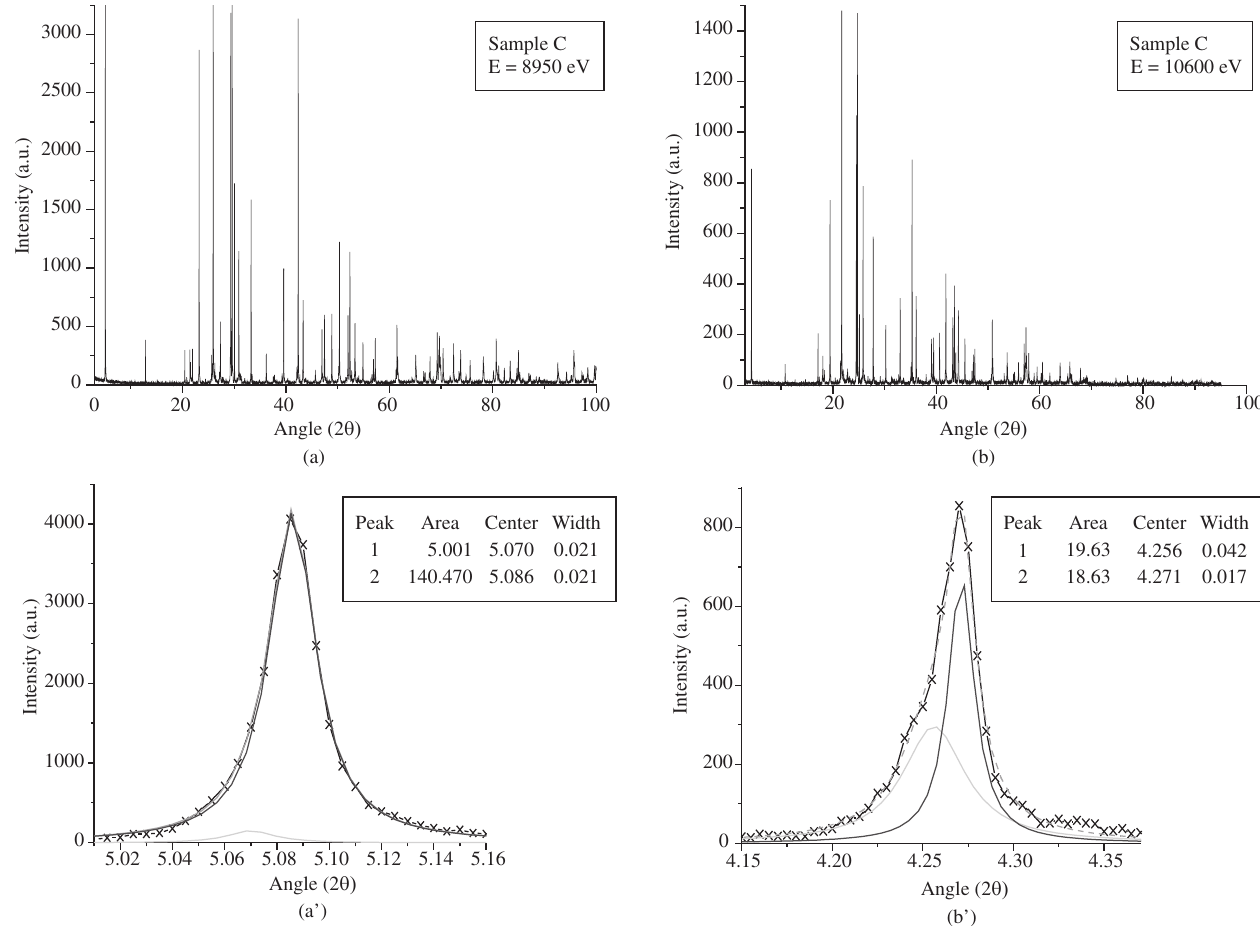
Figure 3. a) Synchrotron anomalous diffraction at energies 8.950 keV and b) 10.600 keV for the same sample. The Figures 3a’ and 3b’ show the asymmetry and different proportions of the split 001 reflection caused by anomalous scattering 12